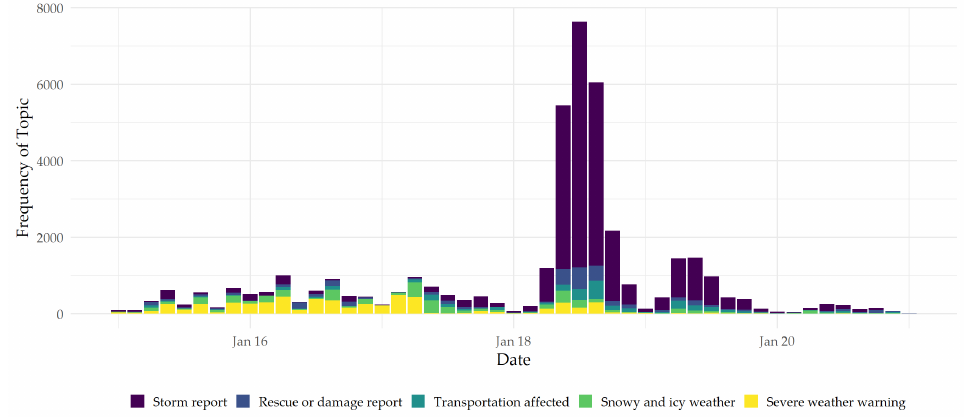
Figure 5. Central topic clusters and their distributions between 15–21 January 2018.